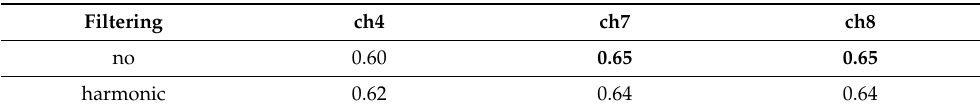
Table 10. A3S-Rec dataset: AUPRC of the baseline model without fine-tuning for ESD across all the recordings of channels 4-7-8.